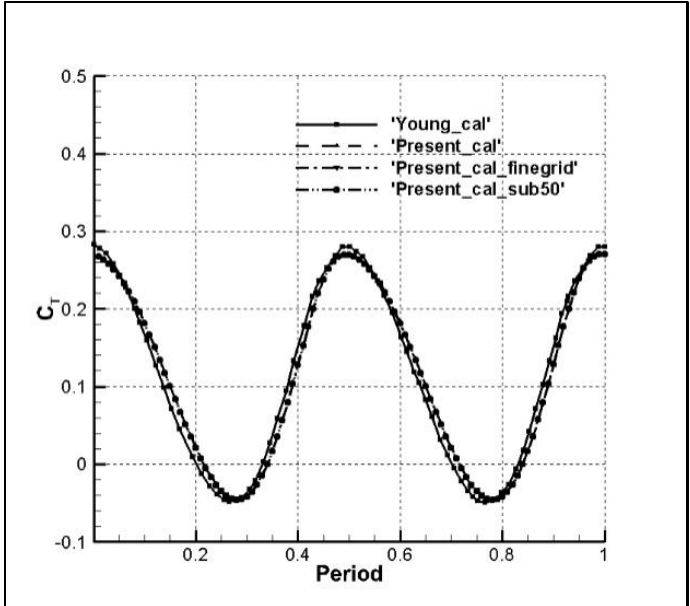
Figure 6. Validation of grid, time steps, and method.